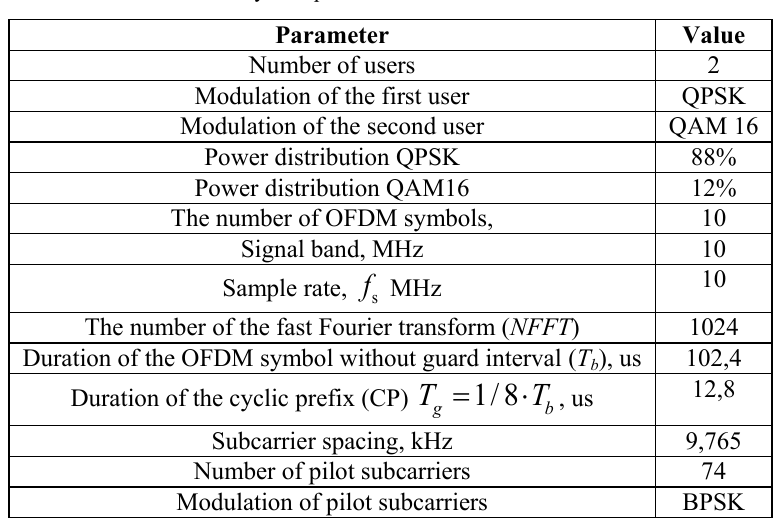
Table 1. System parameters used in the simulation.